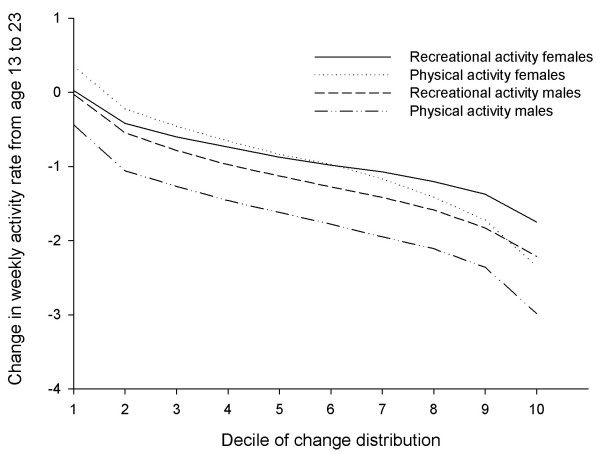
Change in physical and recreational activity from age 13 to 23 by deciles of change distribution and sex.